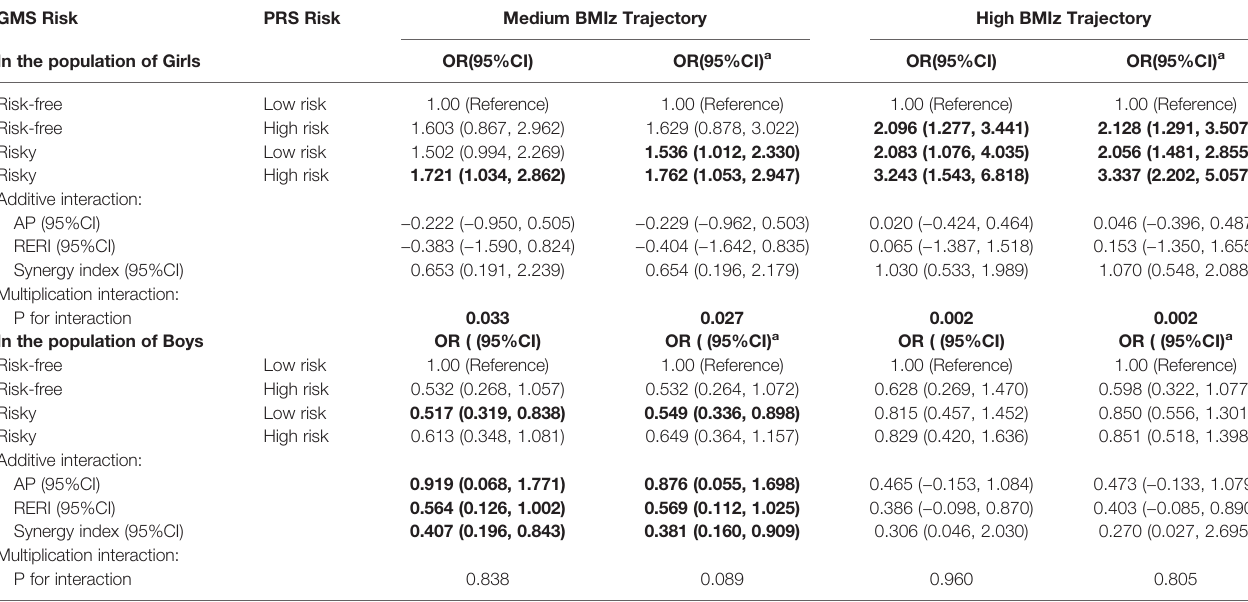
TABLE 5 | Association of the interaction of GMS risk and PRS risk with children ’ s BMIz score trajectory group.